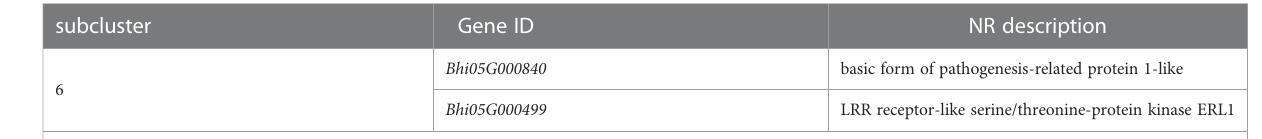
TABLE 3 Genes in subcluster 6 of MAPK signaling pathway –